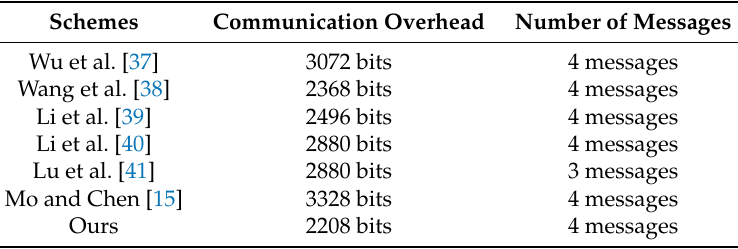
Table 6. Communication overheads